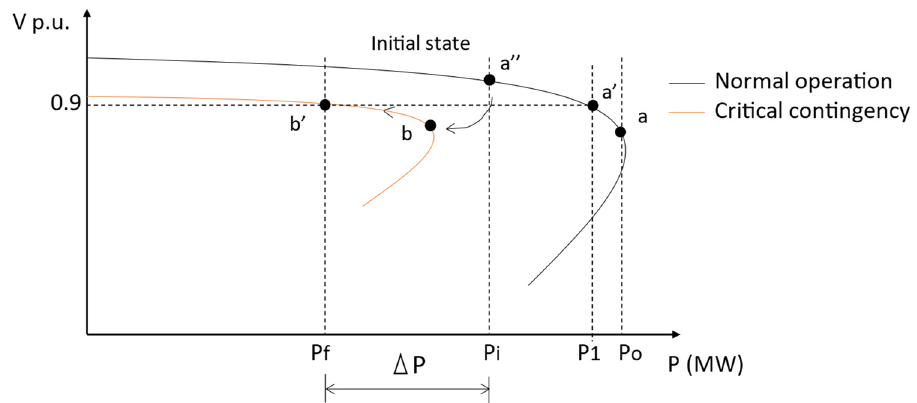
Figure 14. P–V curve for normal and contingency operation (determination of load shedding).